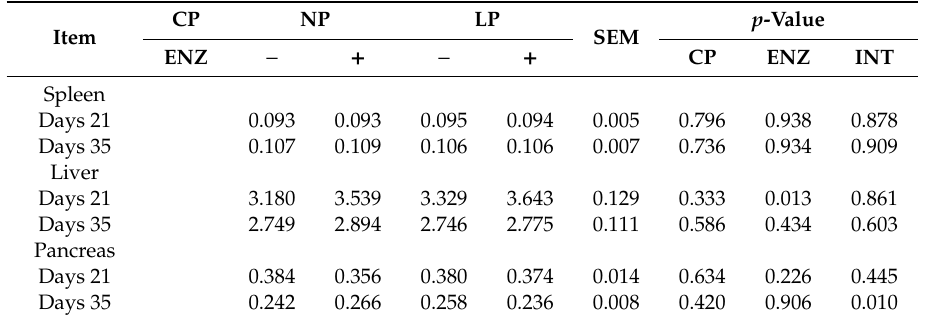
Table 3. E ff ect of low-protein diet and exogenous protease on relative organ weight (g / 100 g of live body weight) in broiler